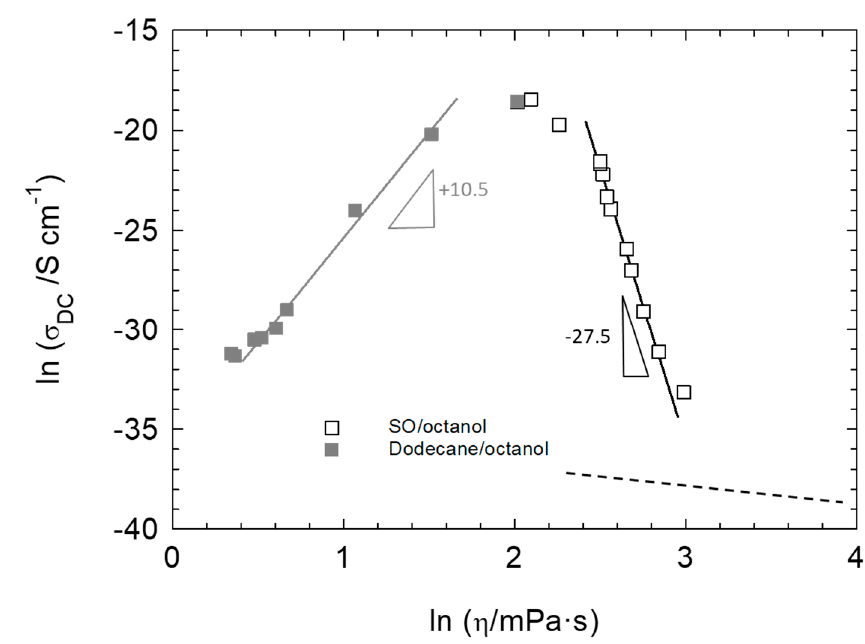
Figure 11. Log–log relationships between DC electrical conductivity ( σ ′ DC ) and viscosity ( η ) for the two octanol-containing mixtures. The solid lines are least squares fits of the intermediate data with the slopes ( α ) indicated. The dashed line represents the Walden slope of − 1.